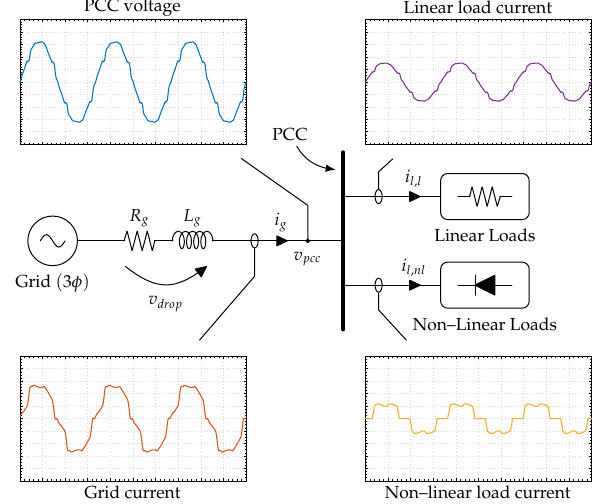
Figure 3. Effects of linear and non-linear loads fed by a weak